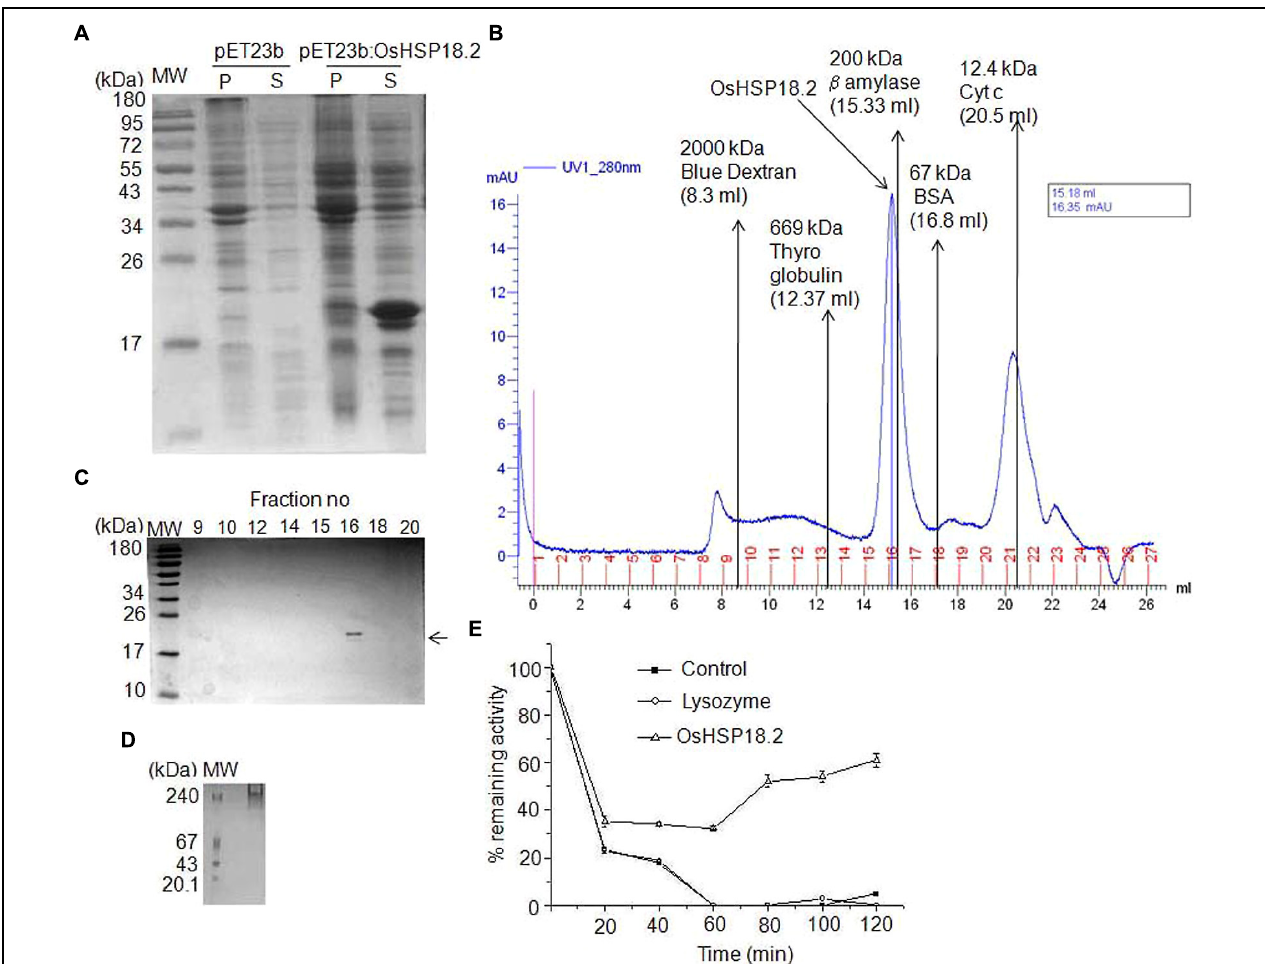
FIGURE 3 | Characterization of recombinant OsHSP18.2. (A) Bacterial overexpression of OsHSP18.2 in Escherichia coli . Proteins were separated on a 15% SDS-PAGE gel. pET23b empty vector transformed cells were used as a control. Pellet (P) and Supernatant (S) were run for control and OsHSP18.2 transformed cells along with the molecular weight marker. (B) Size exclusion chromatography on Superose 6 column revealed the homooligomeric nature of OsHSP18.2. Purified protein and appropriate molecular weight markers were run and their elution time (V e ) to void volume (V o ) ratio (V e /V o ) was plotted against their molecular weight in log scale and fitted in an exponential function where y = 512304e − 4 . 306 x . Approximate molecular weight of OsHSP18.2 was calculated from the above equation as ∼ 202 kDa which reflects dodecameric conformation. (C) Gel filtration fractions as run on 15% SDS-PAGE show a single band of OsHSP18.2 in fraction number 16 corresponding to the gel filtration peak. (D) Five percent native polyacrylamide gel shows a protein band of OsHSP18.2 across the 240 kDa marker band. (E) OsHSP18.2 prevents irreversible thermal inactivation of CS at 38 ◦ C. CS was incubated without HSP (— (cid:2) —), with lysozyme (— ◦ —) and with OsHSP18.2 (— (cid:2) —) at 38 ◦ C for 60 min and then shifted to 22 ◦ C for refolding. CS enzyme activity was assayed at the mentioned time points. Values are the mean ± SE of three independent